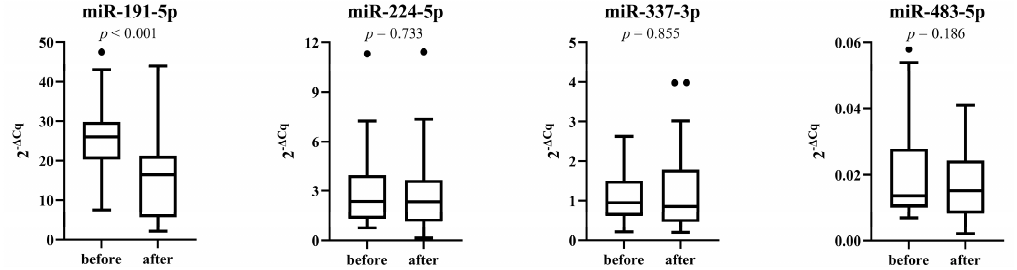
Figure 3. Expression of miRNAs before and after 6 months of placebo phase.